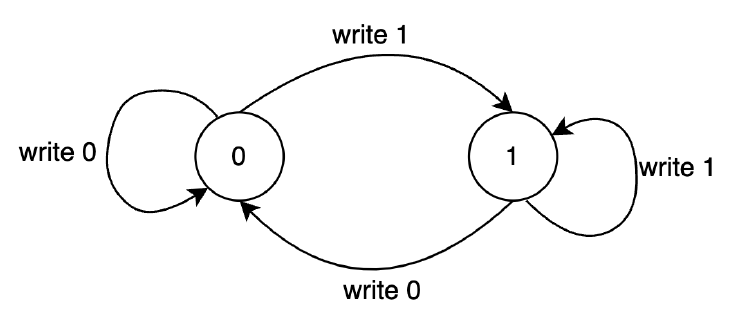
Figure 3. An FSM with states and transitions.